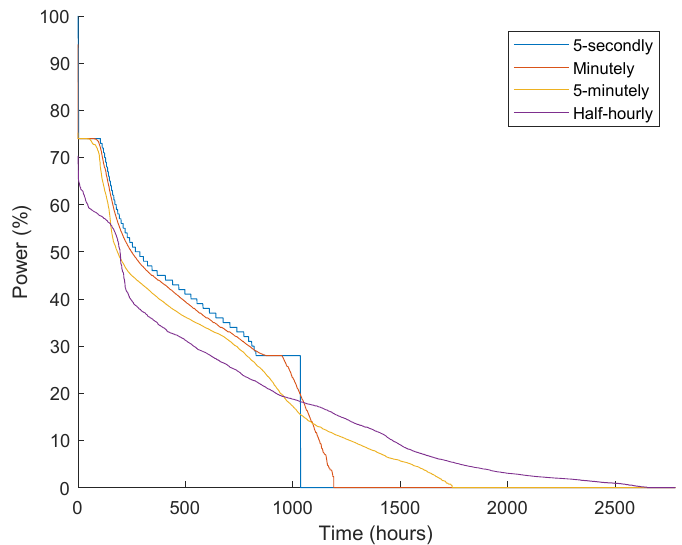
Figure 3. Load Duration Curve at different timescales, OXF1, all heating.